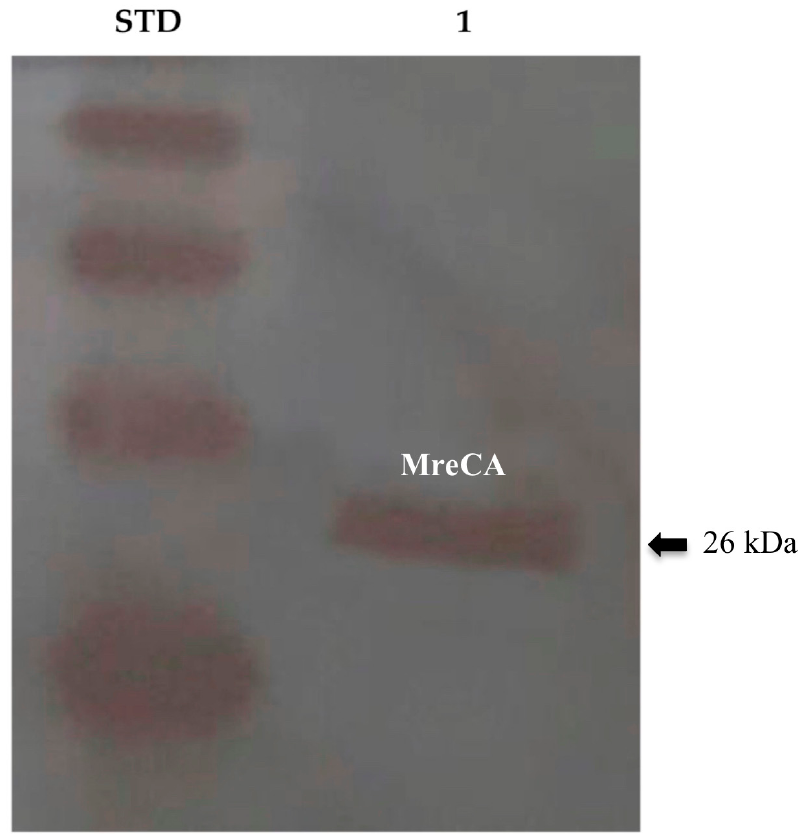
Figure 1. Western blot performed on the purified recombinant MreCA. Legend: Lane Std, MagicMark XP Western Protein Standard, Molecular Weight (M.W.) starting from the top: 50 kDa, 40 kDa, 30 kDa, and 20 kDa, each of which contains an IgG binding site; lane 1, purified MreCA. Bands were identified using the anti-His-Tag antibody.